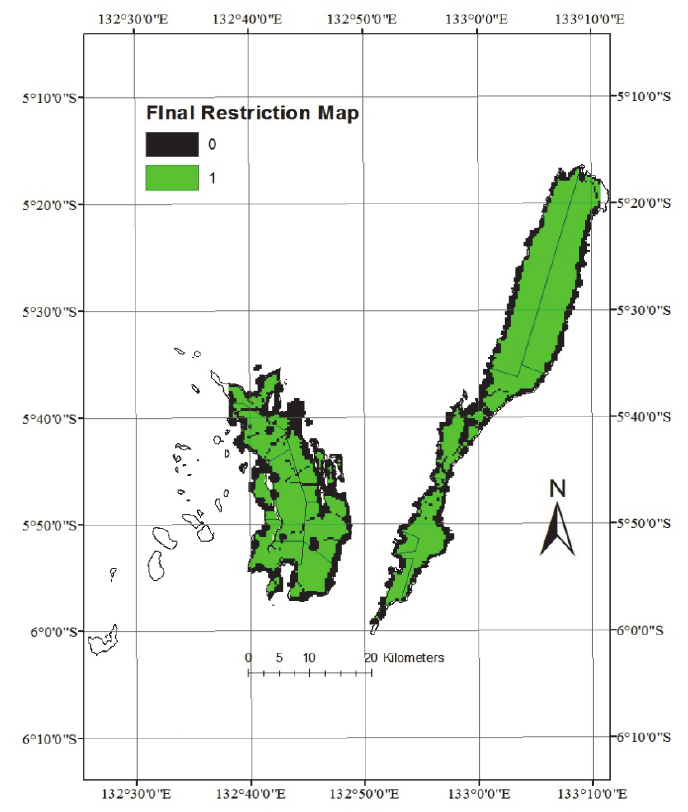
Fig. 4. Final restriction